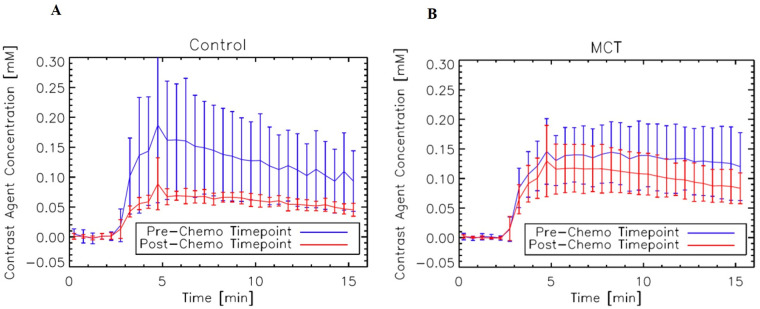
Average DCE enhancement curves of control (A) and MCT (B) mice in each group pre- and post-chemo time points.There is a decrease in enhancement with the control group, while the MCT mice remained fairly level after the scheduled chemotherapy regimen.